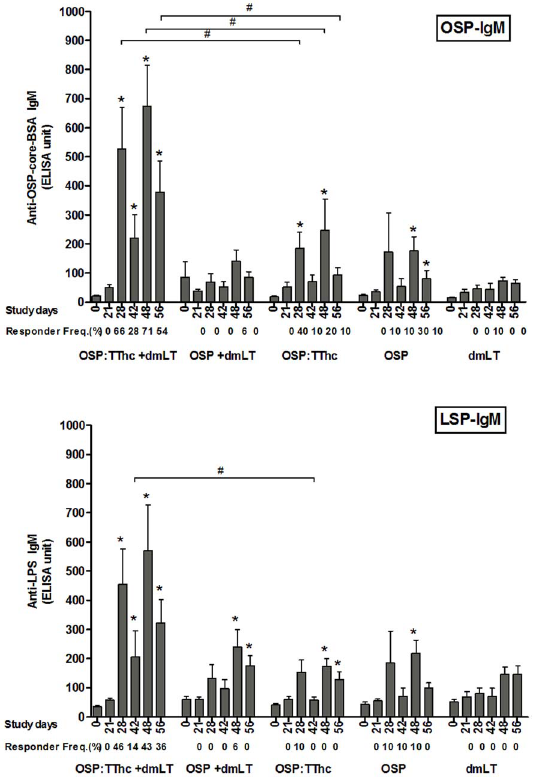
Figure 3. Serum anti-OSP-BSA and anti-LPS IgM antibody responses in mice intramuscularly immunized with OSP:TThc (with dmLT), OSP (with dmLT), OSP:TThc (no dmLT), OSP (no dmLT), or dmLT alone. Mean and standard error of the mean are reported for each group. An asterisk denotes a statistically significant difference ( P , 0.05) from baseline (day 0) titer. Responder frequencies are also listed. # , statistically significant difference among the compared cohorts ( P , 0.05).